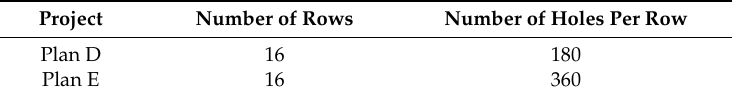
Table 3. Additional simulation schemes.